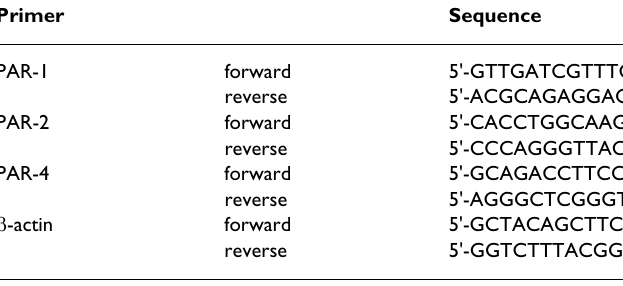
Table 2: Primer sequences for real time PCR analysis